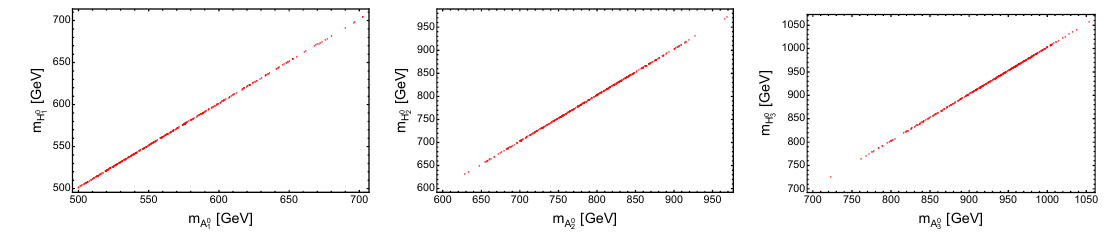
Figure 5 . Linear correlations among the neutral and heavy scalar